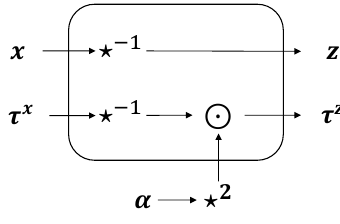
Figure 6: M&M inversion: Obtaining the value and tag shares of z = x −